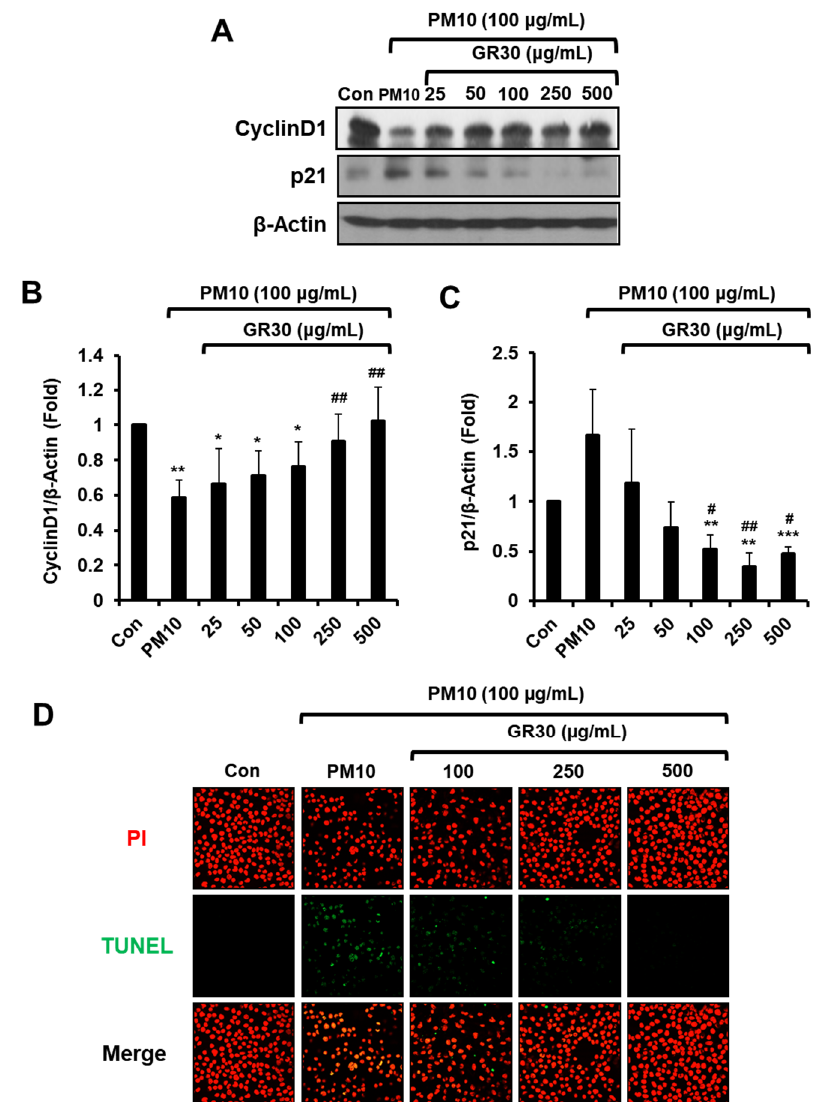
Figure 2. Effects of PM10 and GR30 on cell cycle arrest and DNA fragmentation. ( A ) Cells were pretreated with GR30 (25–500 μ g/mL) for 2 h and then incubated with PM10 for 48 h. Cell lysates were analysed by Western blot analysis for p21 and cyclinD1. β -Actin was used as a loading control. ( B , C ) Protein levels of ( B ) cyclinD1 and ( C ) p21 were quantified by densitometric analysis. The data are expressed as the fold normalized to the untreated control (Con). Each value was presented as the means ± SD ( n = 3). *, p < 0.05; **, p < 0.01; ***, p < 0.001, compared to the untreated control cells (Con). #, p < 0.05; ##, p < 0.01, compared to the PM10-treated cells (PM10). ( D ) DNA fragmentation was assessed by TUNEL staining (green) and counterstaining with PI (red). The stained cells were mounted with a mounting solution and visualized using fluorescence microscopy